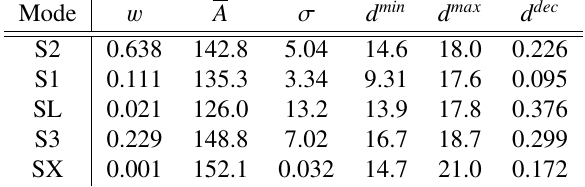
modes to Y ( A , TKE ) sampled from the current Gaussian implementation within CGMF. This gives much more accurate results for (cid:104) TKE (cid:105) and ¯ ν (last row of Table 1). The corresponding Brosa parameters are listed in Table